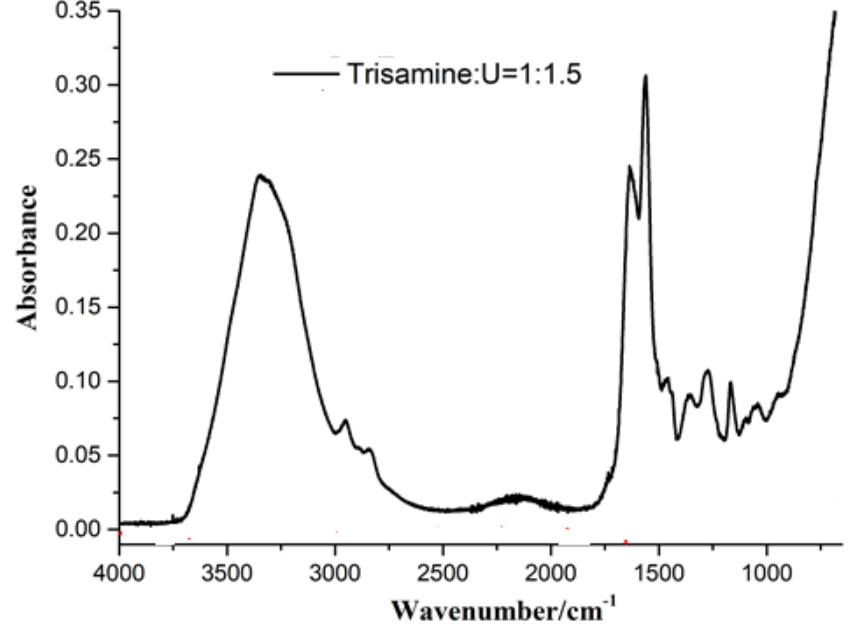
Figure 4. FTIR of the hyperbranched reaction product of tris (2–amino ethyl) amine with urea.